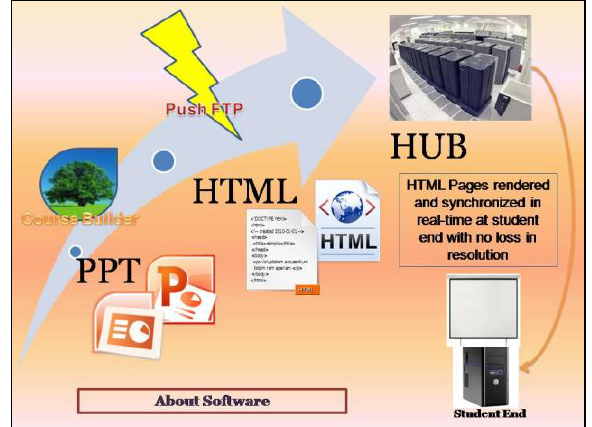
Table 4. Course Curriculum of IIRS EDUSAT Program